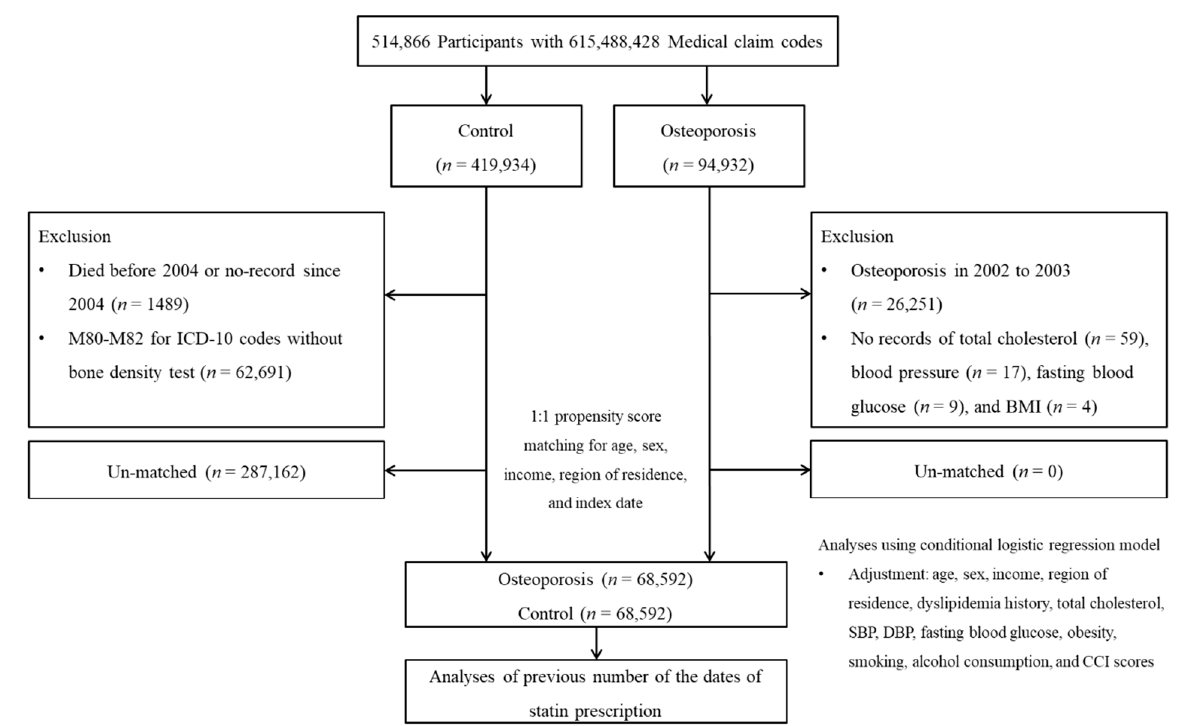
Figure 1. A schematic illustration of the participant selection process that was used in the present study. Of a total of 514,866 participants, 68,592 osteoporosis participants were matched 1:1 with 68,592 control participants for age, sex, income, and region of residence using propensity score matching. Abbreviation: BMI, body mass index.